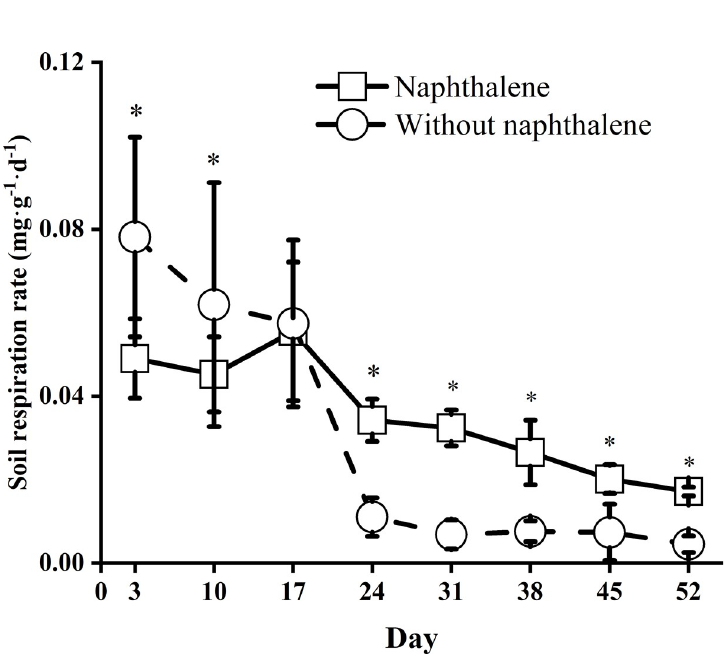
Fig 1. Soil microbial respiration rates in subalpine forest soil of microcosms treated with and without naphthalene. Asterisks indicate significant ( � P < 0.05) differences between the treatments with naphthalene and without naphthalene at the same sampling